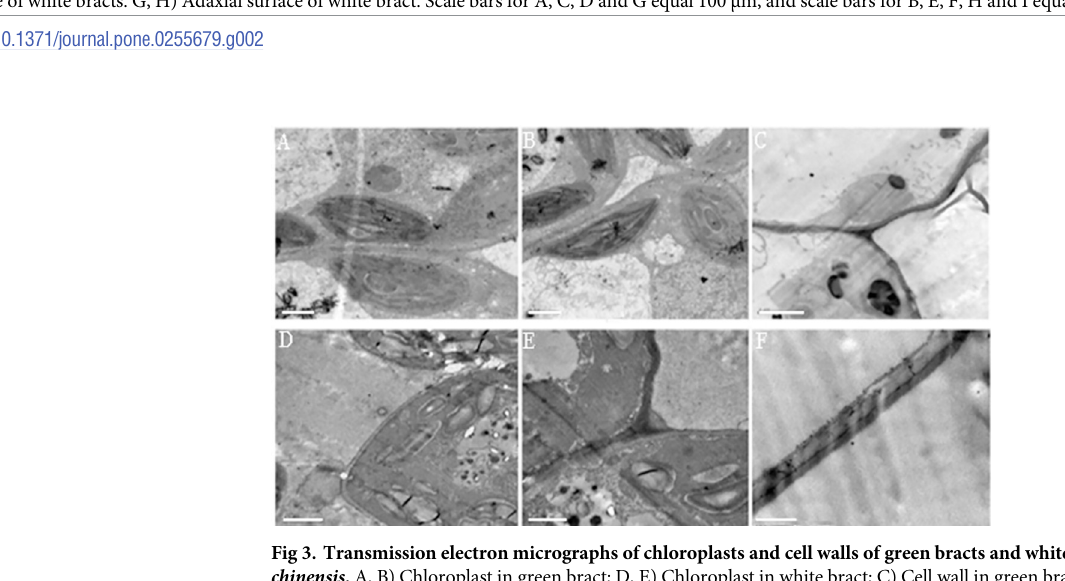
PLOS ONE | https://doi.org/10.1371/journal.pone.0255679 September 2,